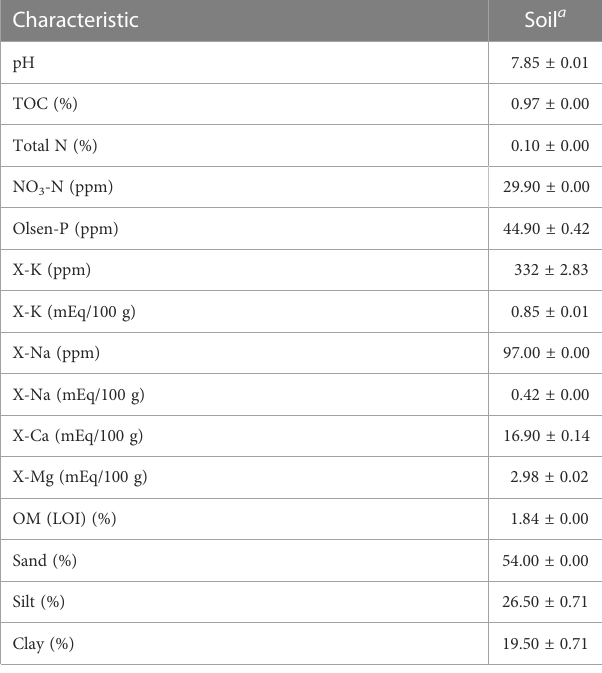
farm) in the Salinas Valley. Characteristic Soil